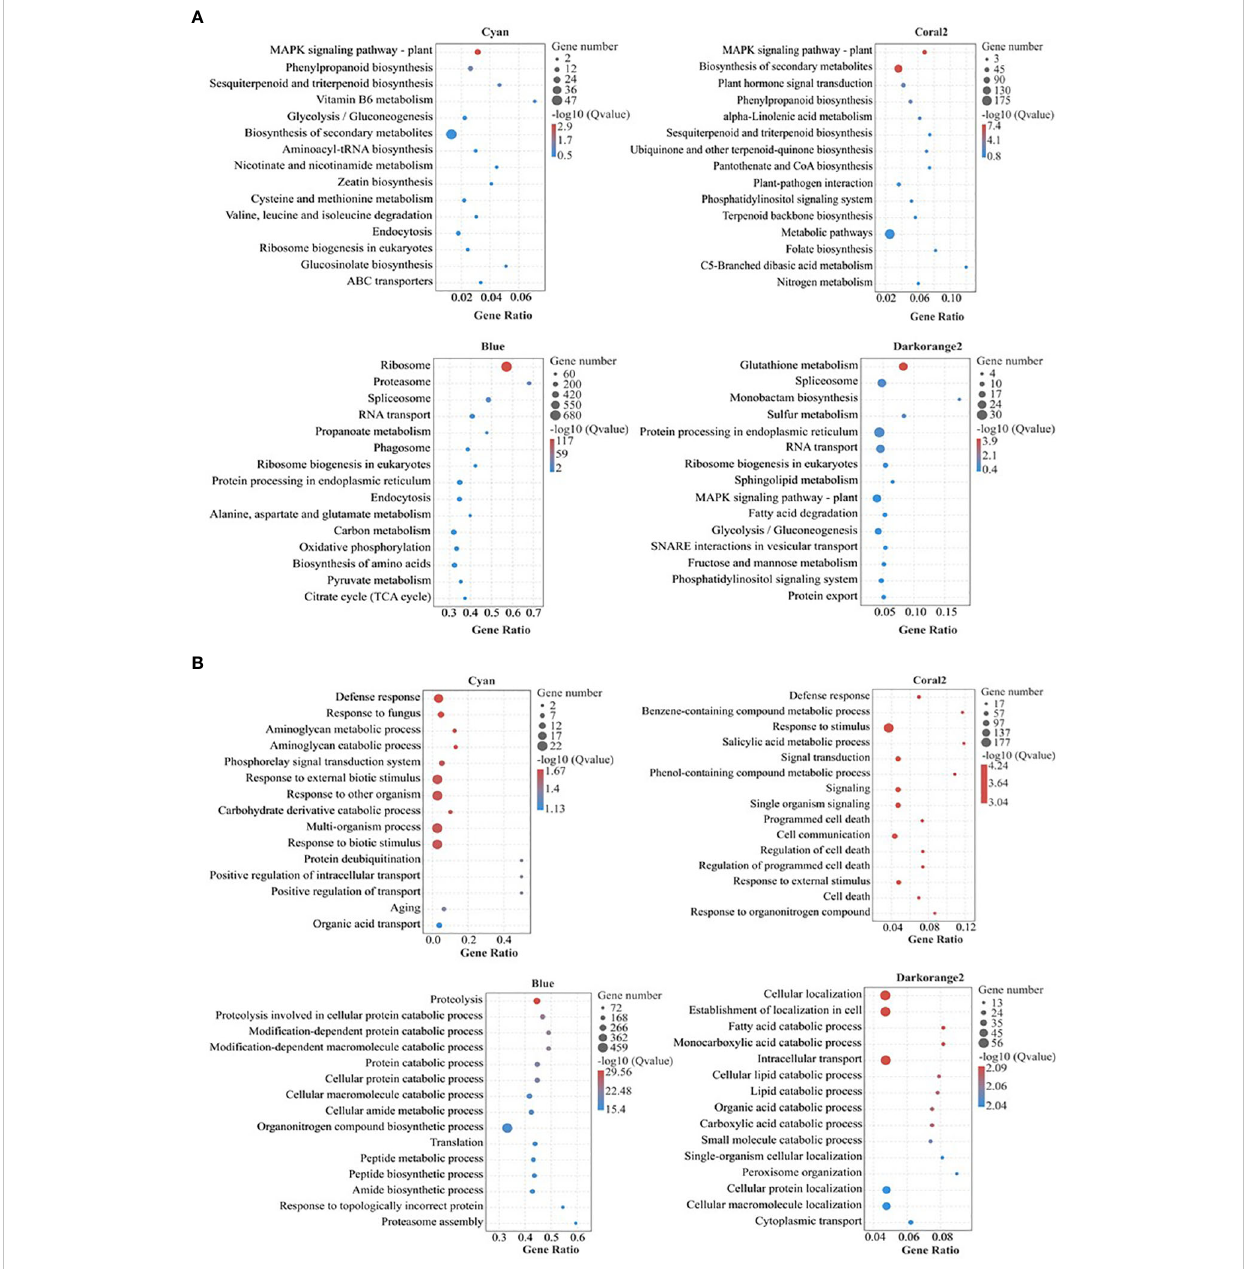
FIGURE 5 Bubble diagram of KEGG and GO pathway enrichment of selected key modules. (A) KEGG pathway enrichment; (B) GO pathway enrichment (Biological process); Gene Ratio, the ratio of the number of genes enriched to each GO term to the total number of genes analyzed by GO. Pathways meeting the condition of Q value ≤ 0.05 were de fi ned as signi fi cantly enriched